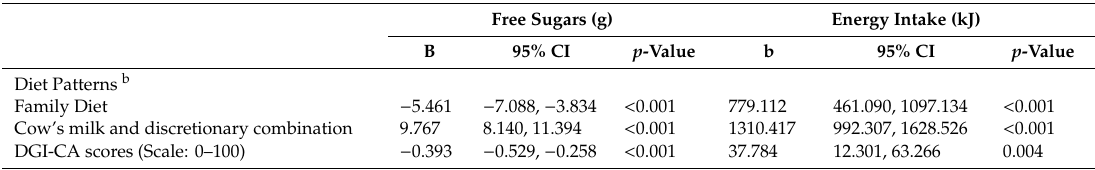
Table 4. Associations between dietary patterns at 12 months and intake of free sugars (g) and total energy intake (kJ), after adjusting for covariates a